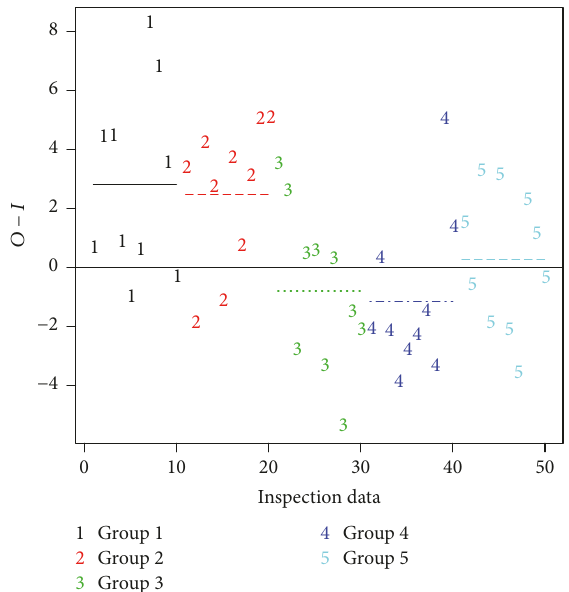
Figure 2: Values of 𝑑 = 𝑂−𝐼 in data simulated from (7) with 𝑛 = 10 , 𝑔 = 5, 𝜎 = 1, 𝜎 = 0.1, 𝜎 = 3, 𝜎 = 1, 𝜇 = 100 , and the 𝑅𝑂 𝑆𝑂 𝑅𝐼 𝑆𝐼 True SD of the true values 𝜎 𝜇 = 1